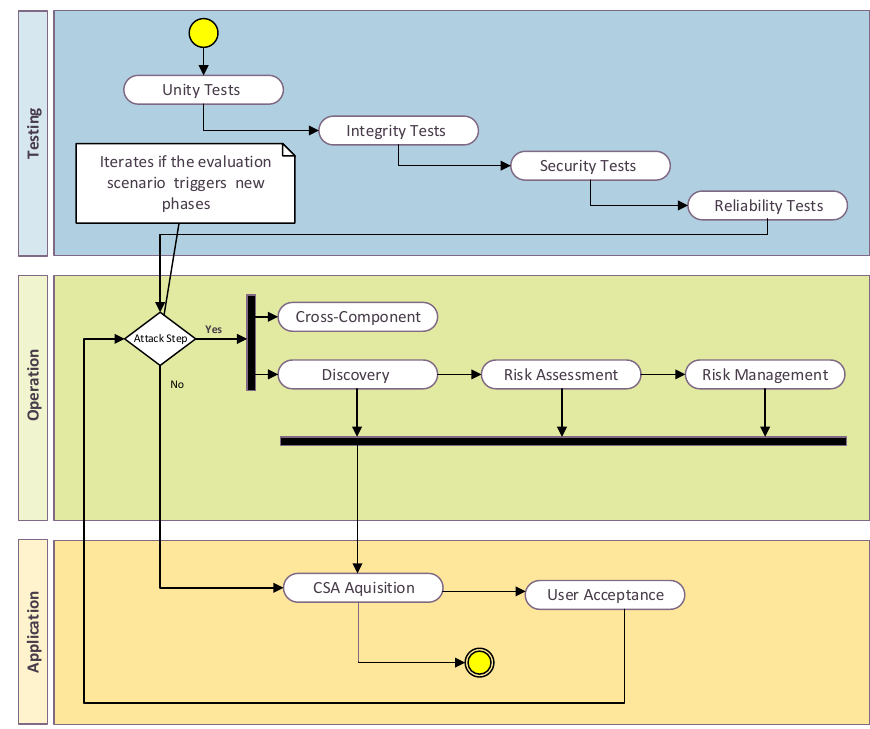
Figure 7. Action diagram of the evaluation